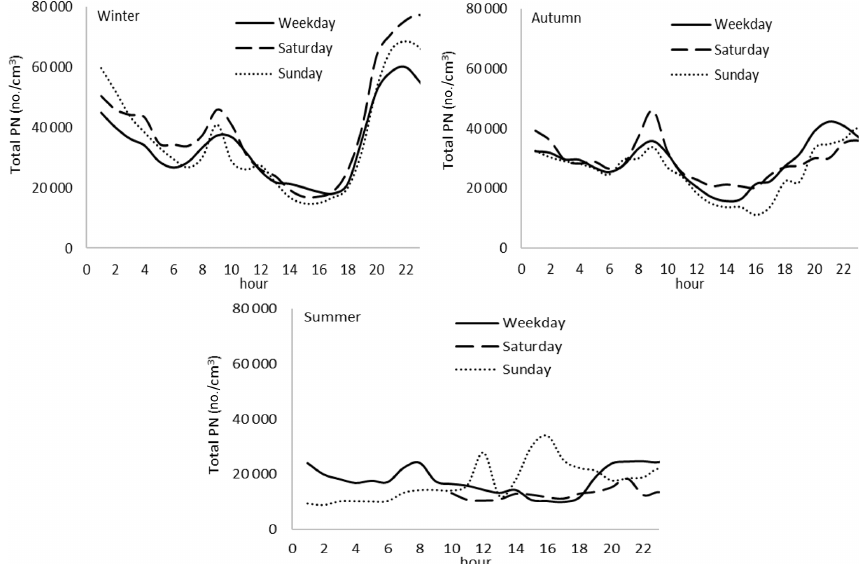
Figure 3. Average diurnal variation in the total particle number counts (between 15 and 10µm) for the weekday average (Monday to Friday), Saturday, and Sunday in Delhi. Summer data are very limited. There are no data for Friday afternoon and night nor for Saturday in the early morning (Fig.